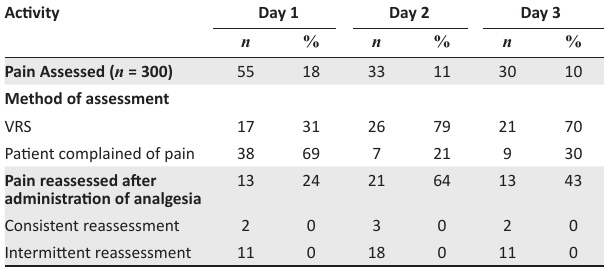
TABLE 3: Frequency and method of pain assessment and reassessment.